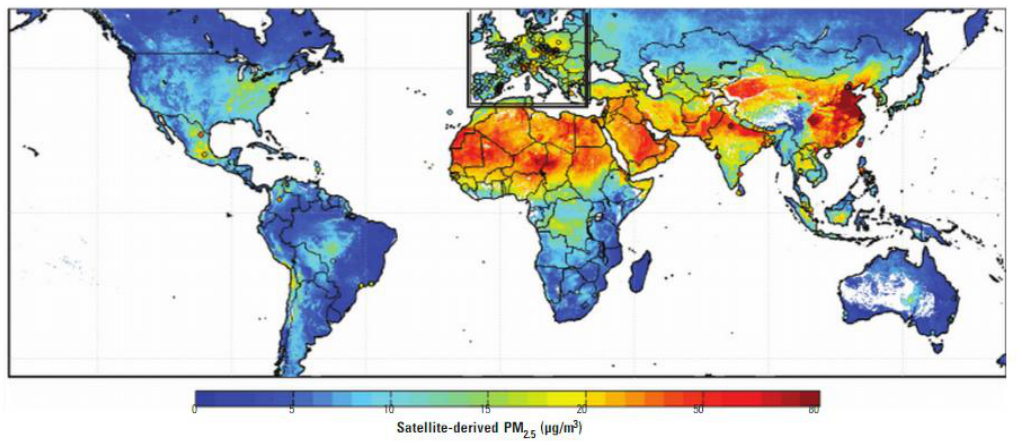
Figure 1. Global satellite-derived PM2.5 concentration